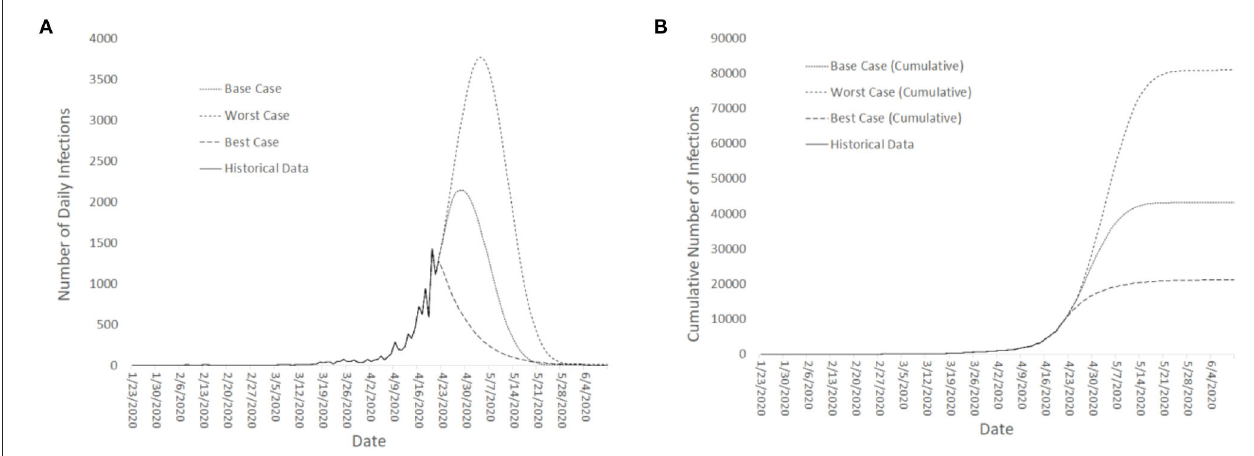
FIGURE 2 | Short-term (month ahead) projections for: (A) Number of confirmed COVID-19 new cases, and; (B) Cumulative number of total COVID-19 Cases (in Singapore).